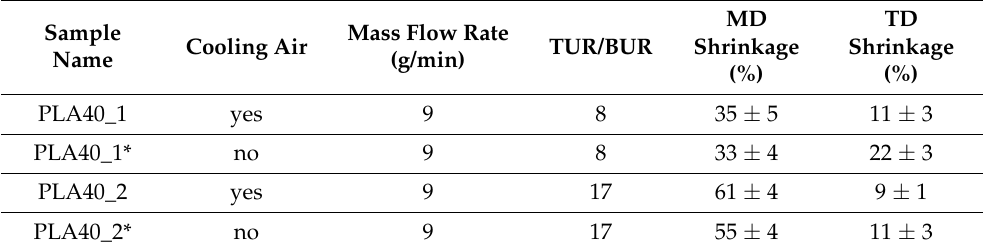
Table 3. Extrusion blowing parameters and thermal shrinkage for films made of PLA40 blend. Films with an asterisk are those produced without cooling